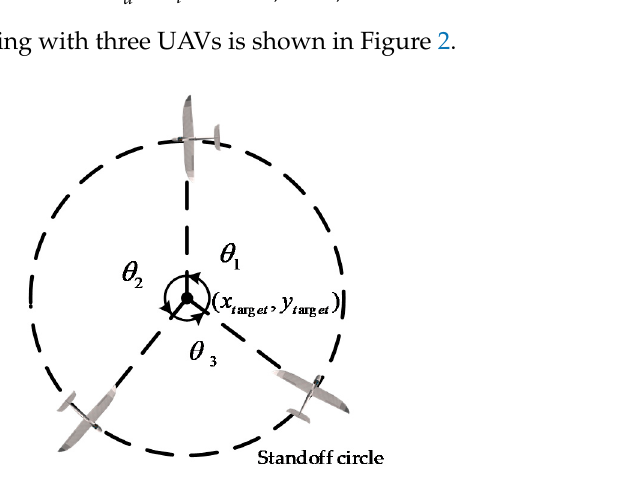
Figure 2. Scenario of phase keeping in standoff target tracking.